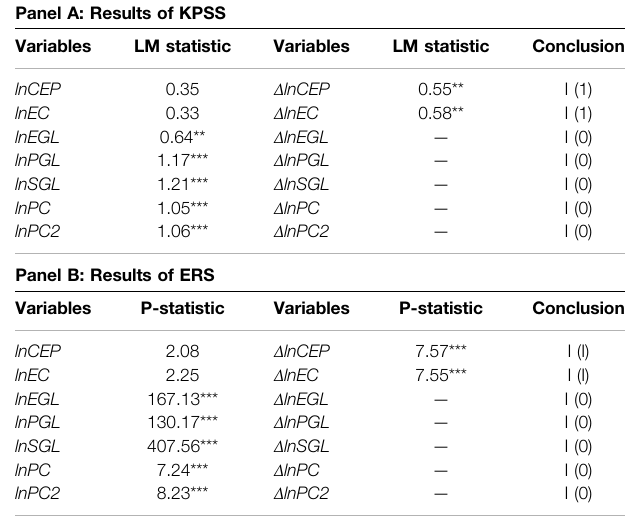
TABLE 2 | Descriptive statistics.